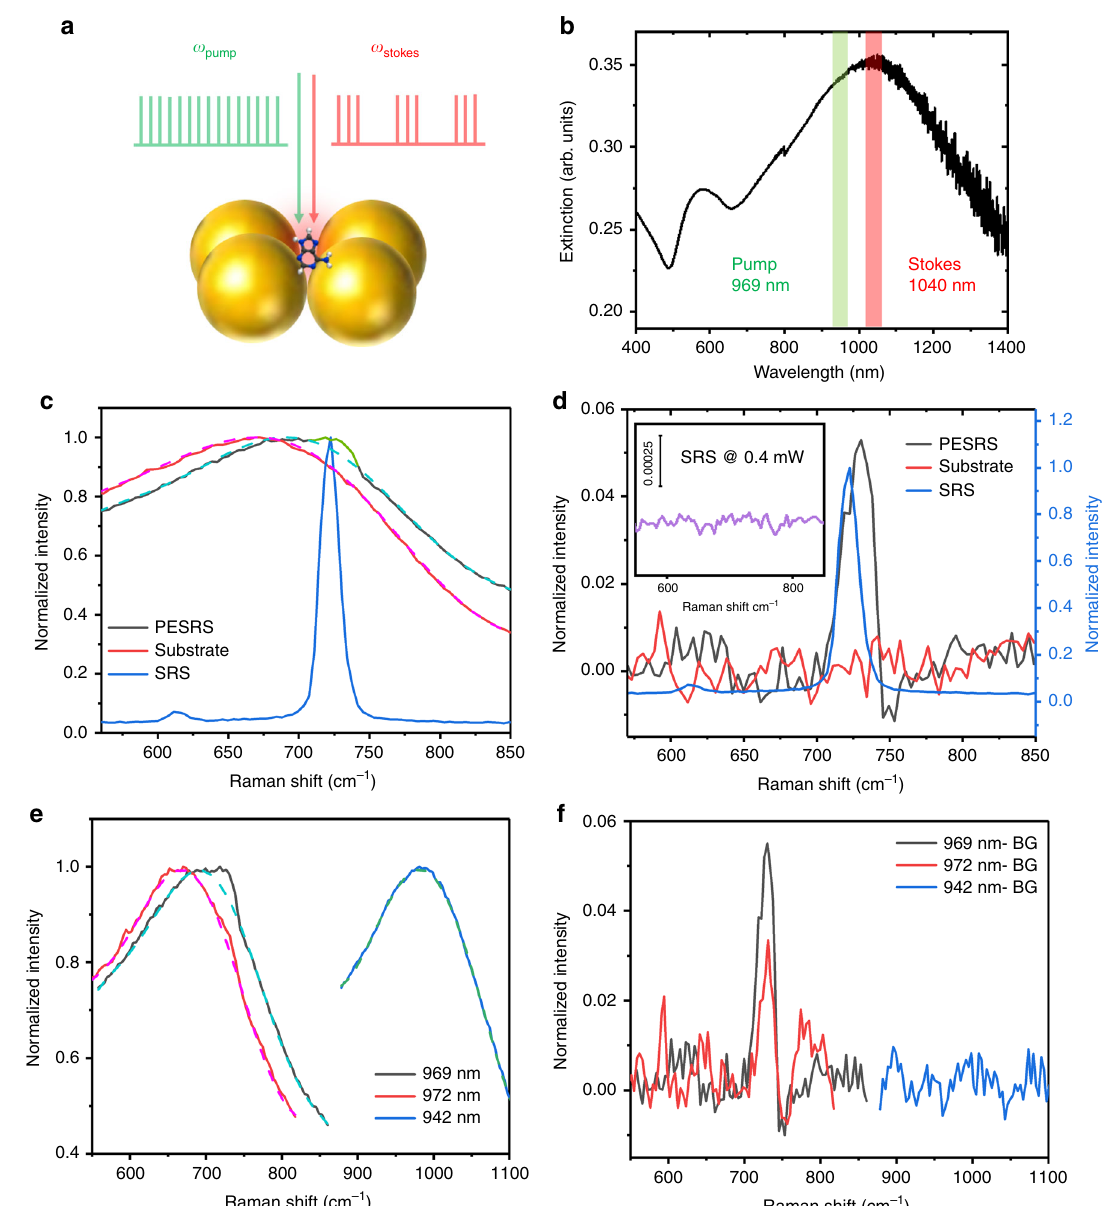
Fig. 1 PESRS spectroscopy. a A schematic of PESRS. b A representative extinction spectrum of adenine-induced Au NPs aggregation substrate. c The PESRS spectrum (solid) with a green highlighted portion and fi tted background (dash) obtained from the substrate with adenine adsorption. The blank spectrum (solid) and fi tted background (dash) obtained from the substrate without adenine. The total power of pump and Stokes was 0.4 mW. The SRS spectrum of adenine powder (blue) was obtained with a pump power at 10 mW and a Stoke power at 50 mW. d The background-subtracted PESRS spectrum of adsorbed adenine versus the SRS spectrum of adenine powder (same as blue line in c ) and the spectrum of blank substrate. Inset: The SRS spectrum of adenine powder obtained as the same laser power condition as the PESRS. e PESRS spectra (solid) and fi tted background (dash) of adenine at Raman resonance (969 nm and 972 nm) and off-resonance (942 nm). f Background-subtracted PESRS spectra of adenine at Raman resonance and off-resonance. BG: fi tted backgrounds were shown as dash lines), the PESRS spectra To verify that the SRS signal is due to the adenine vibrational of adenine excited by both Raman resonance wavelengths show a resonance, we vary the pump wavelength while keeping the Raman peak at 733 cm − 1 (black and red, Fig. 1f), whereas the off- Stokes wavelength fi xed. The pump laser centered at 972 nm, as resonance spectrum only shows a noisy featureless baseline (blue, well as the previous 969 nm wavelength encompass the adenine Fig. 1f). Moreover, as shown in Supplementary Fig. 3, the Raman resonance for a 1040 nm Stokes pulse, and both generated intensity of the 733 cm − 1 peak linearly depends on the pump SRS spectra showing a pronounced peak at the expected power and the Stokes power before it reaches saturation. To wavenumber (Fig. 1e, black and red). In contrast, the 942 nm is evaluate the degree of photodamage, we continually measured a off-resonance for the 733 cm − 1 band. Accordingly, the measured 1-mM adenine PESRS sample at the same location (Supplemen- spectrum does not exhibit such a peak as shown in Fig. 1e (blue). tary Fig. 4 and Supplementary Movie 1). About 20% of the signal After subtraction of the background in Fig. 1e (corresponding